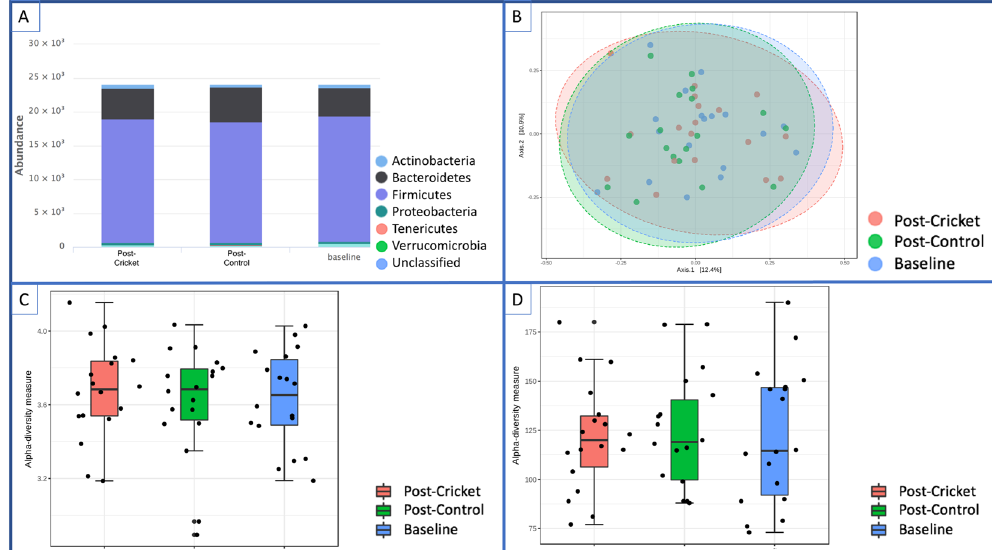
Figure 4. Changes in Participant Microbiota at Baseline, Post-Cricket, and Post-Contro. ( A ) Phyla-level bacterial composition of stool samples for all participants at baseline and post-interventions suggests global stability of the microbiota across treatments. ( B ) Principle Coordinates Analysis (PCoA) projecting Bray-Curtis distances. ( C ) Shannon diversity scores, and ( D ) Chao richness estimates further confirm global microbiota stability across diet